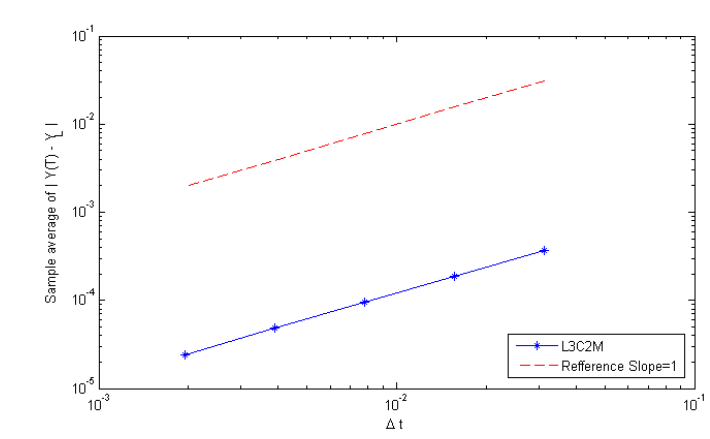
Figure 7. The MS error for the